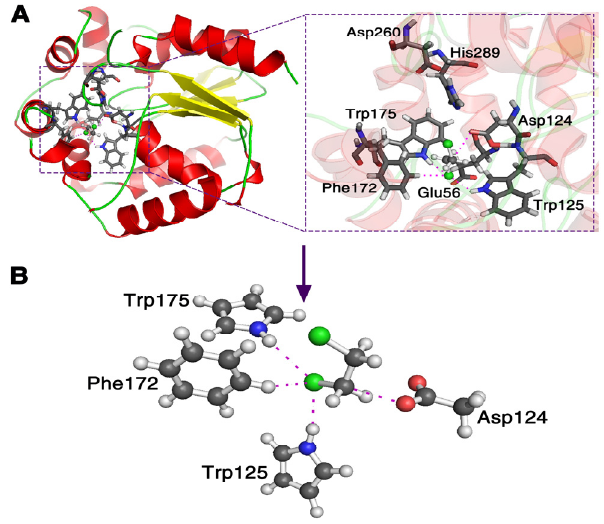
Figure 1. Theoretical model of the enzyme haloalkane dehalogenase (DhlA) catalytic reaction with 1,2-dichloroethane (PDB code 2DHC in ( A )). The side chain Asp124 ( Asp − 𝐶𝑂 (cid:2870)(cid:2879) ) in the DhlA is replaced with 𝐶𝐻 (cid:2871) 𝐶𝑂 (cid:2870)(cid:2879) and three residues of Trp125, Trp175 and Phe172 are reduced using their active sites, respectively, in ( B ).